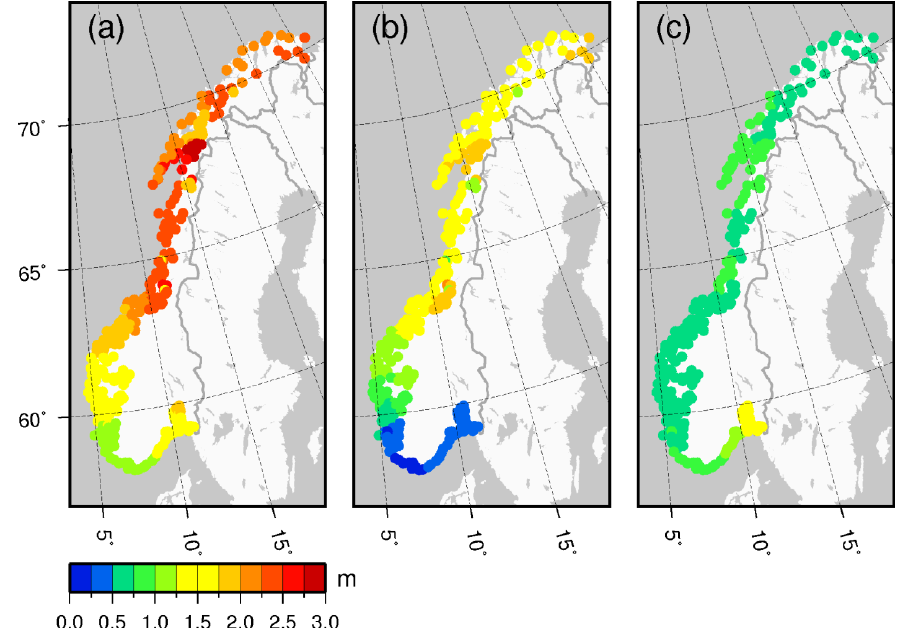
Figure 4. Water levels extrapolated to the 290 coastal municipalities in Norway: ( a ) the 200-year return height in meters above mean sea level; ( b ) highest astronomical tide (HAT) in meters above mean sea level; and ( c ) the 200-year return height in meters above HAT in order to compare the significance of the extreme levels.